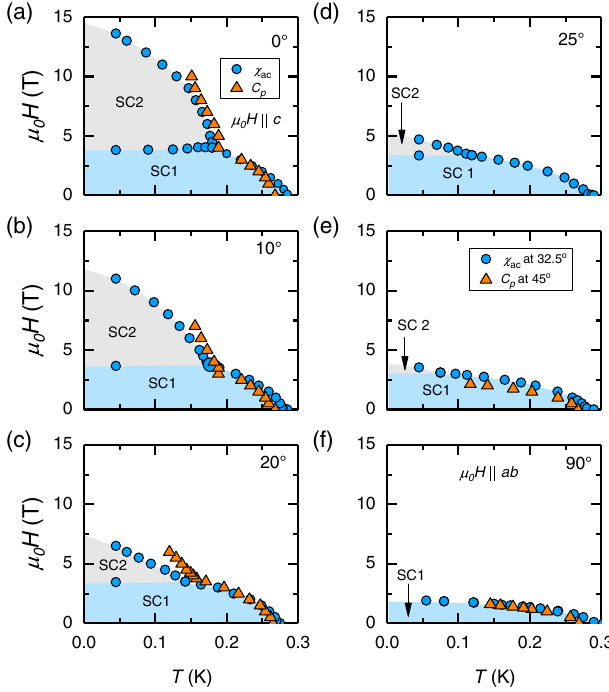
FIG. 4. (a) – (f) Magnetic field-temperature phase diagrams of CeRh 2 As 2 for different directions of the magnetic field. The experimental points are from ac susceptibility and specific heat, as indicated. The data shown in (a) and (f) were taken from Ref.